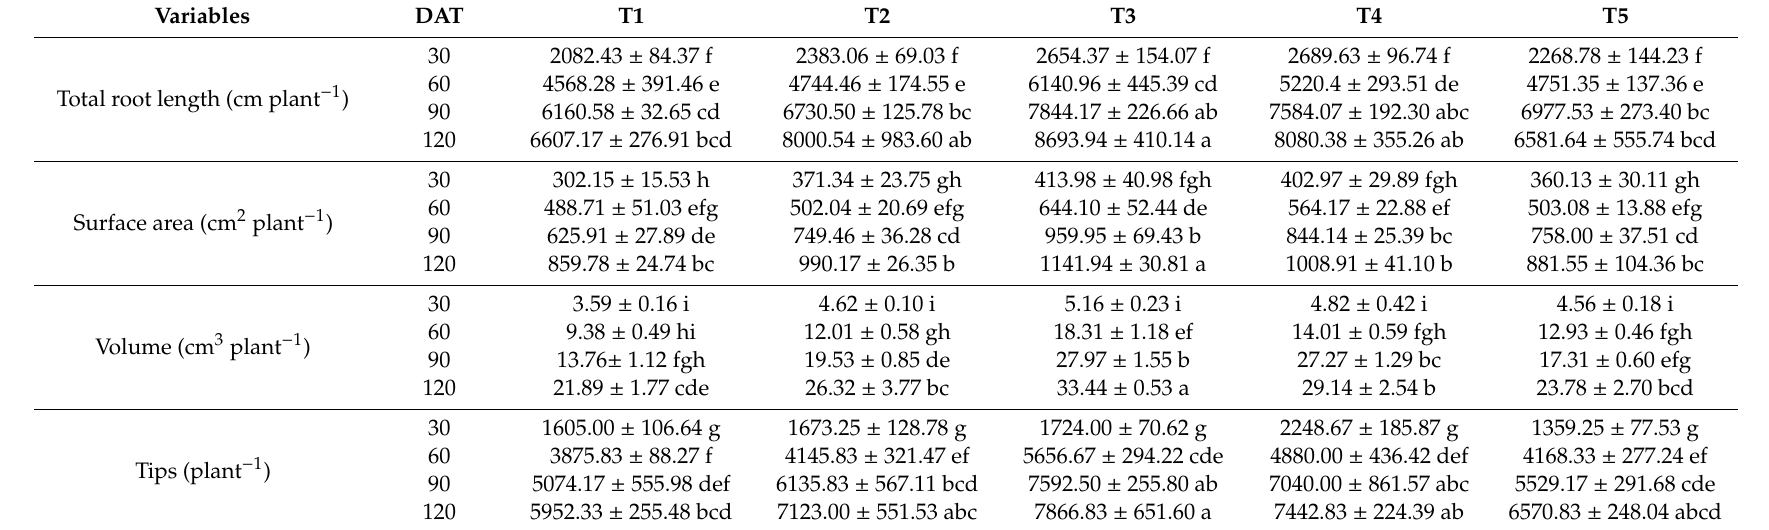
Table 4. E ff ects of NH 4 + :NO 3 − ratios on root morphological parameters of